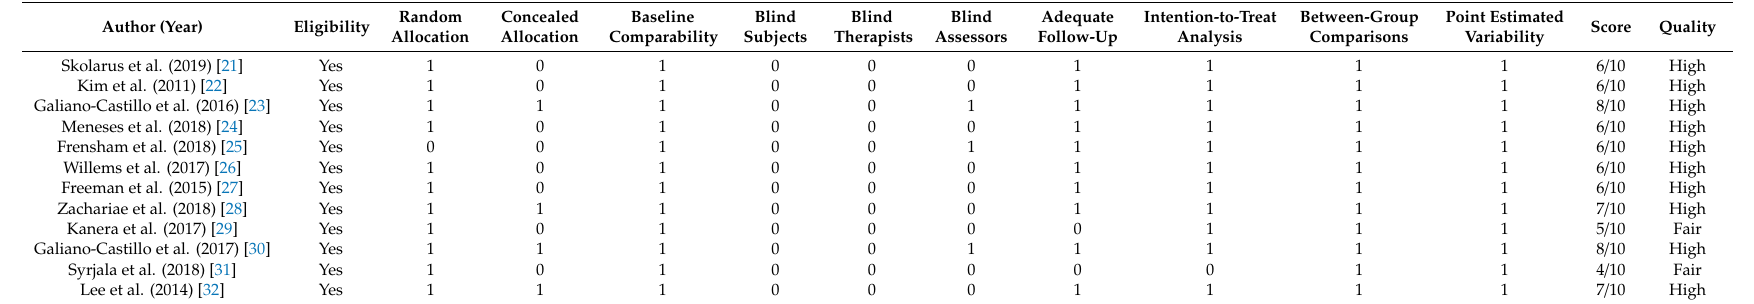
Table 1. PEDro scale scores for each study.